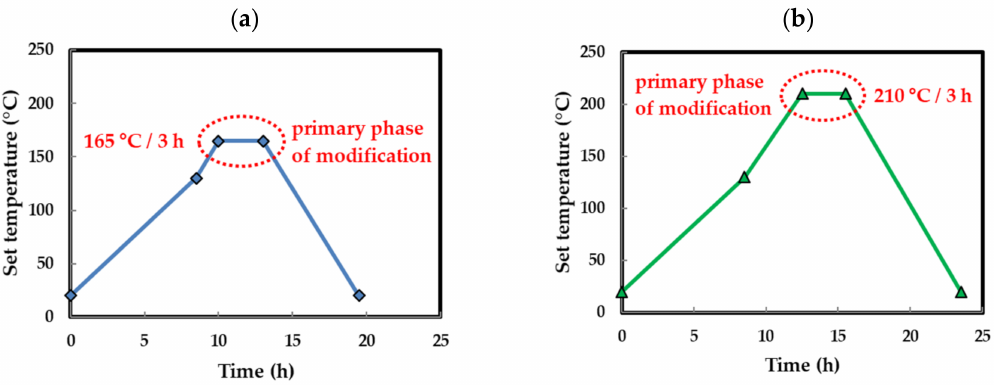
Figure 3. Diagram of the heat treatment procedure at 165 ◦ C ( a ) and 210 ◦ C ( b